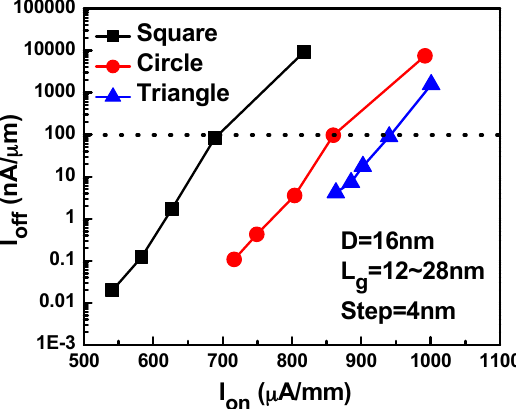
Figure 3. The relationship between the off-state and the on-state current of different cross-sectional GAA SNWTs with varying gate length.